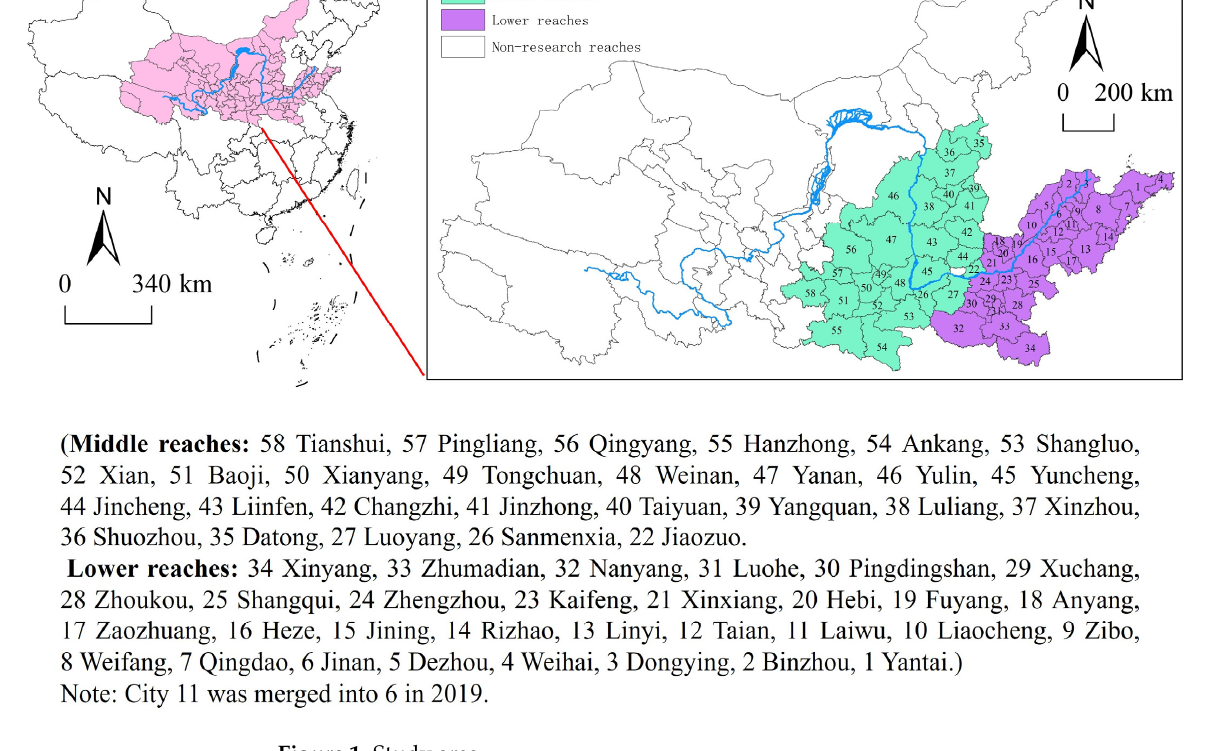
Figure 1. Study area.